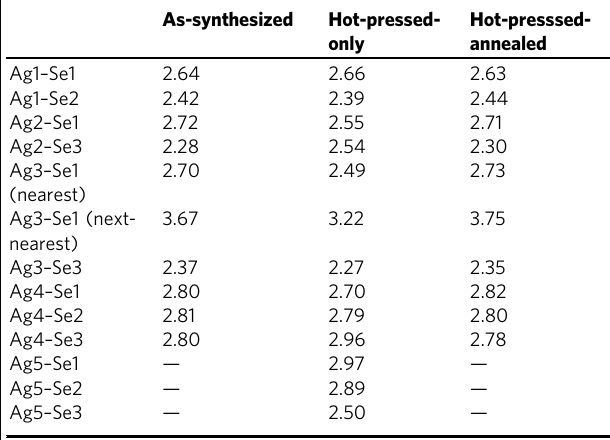
Table 1 Selected bond distance (Å) of single crystals obtained by as-synthesized, hot-pressed-only, and hot- pressed-annealed